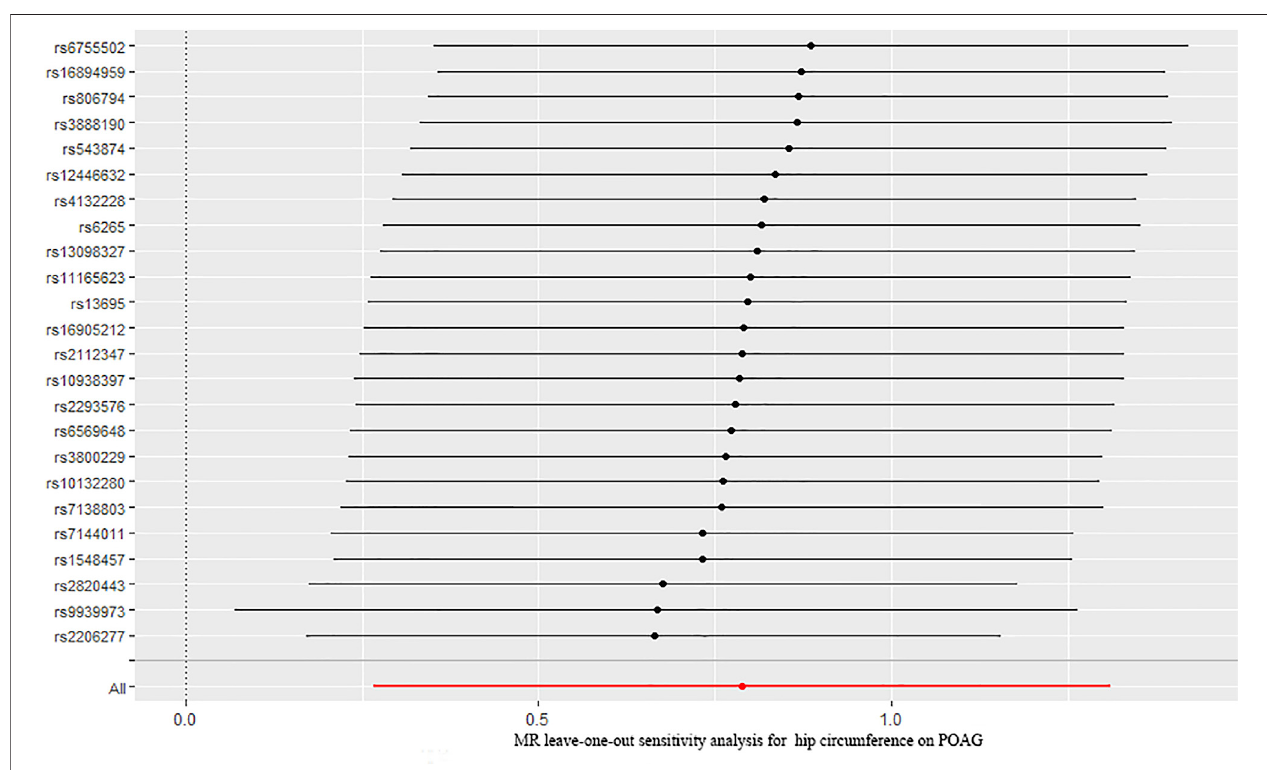
FIGURE 5 | Leave-one-out analysis plots for hip circumference on the risk of POAG. POAG: primary open-angle glaucoma; MR: Mendelian